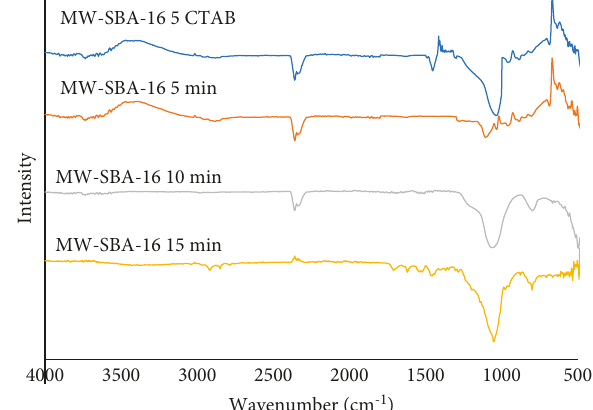
Figure 2: FT-IR spectra of all samples prepared by the microwave